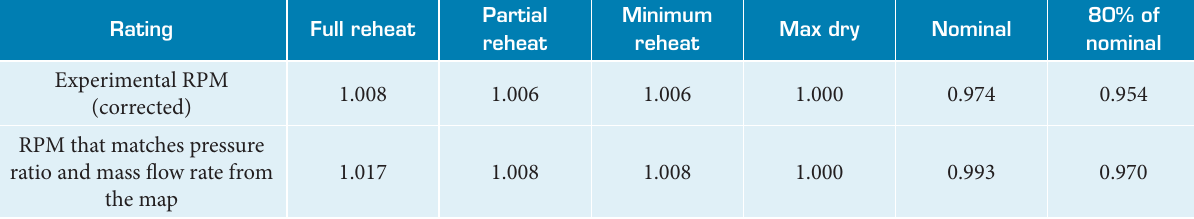
Table 2. N2 RPM (revolutions per minute) corresponding to off-design ratings from map and from experiments.